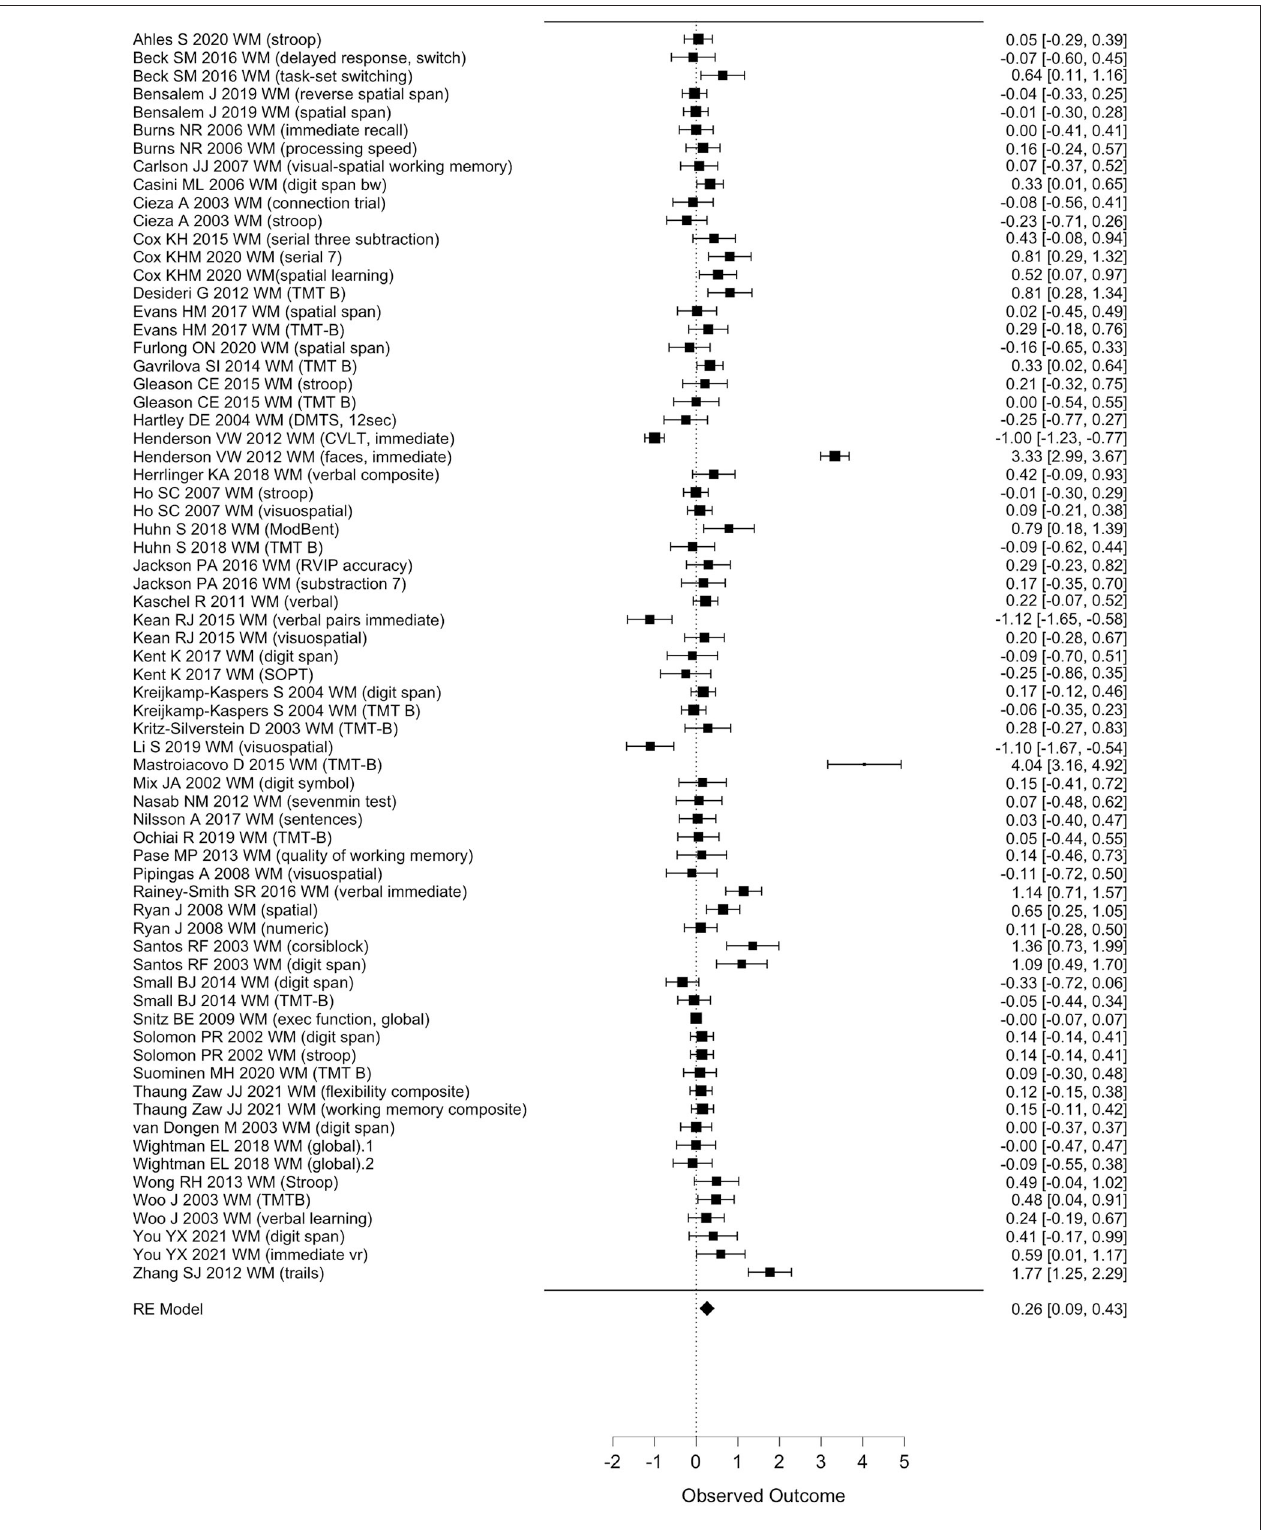
FIGURE 2 | Forest plot for observed effect sizes (d) and standard errors (SE) for available study results for WM. RE, regression estimate.